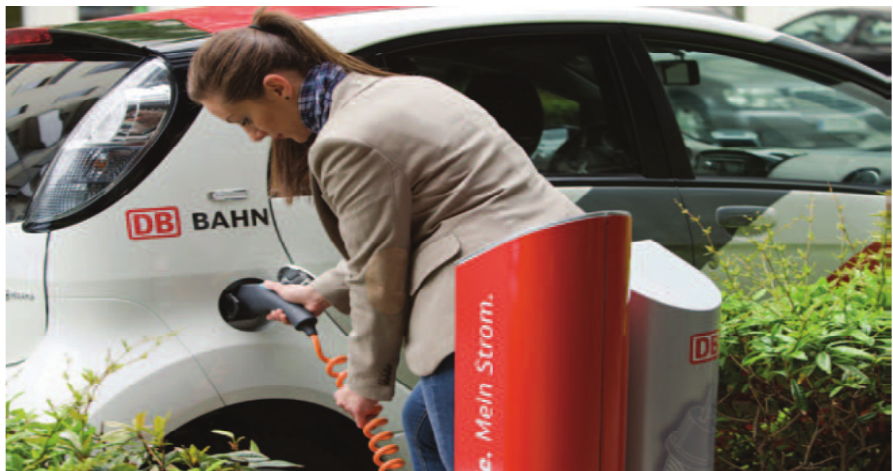
Figure 7: Deutsche Bahn has led the integration of electric mobility with public transport in